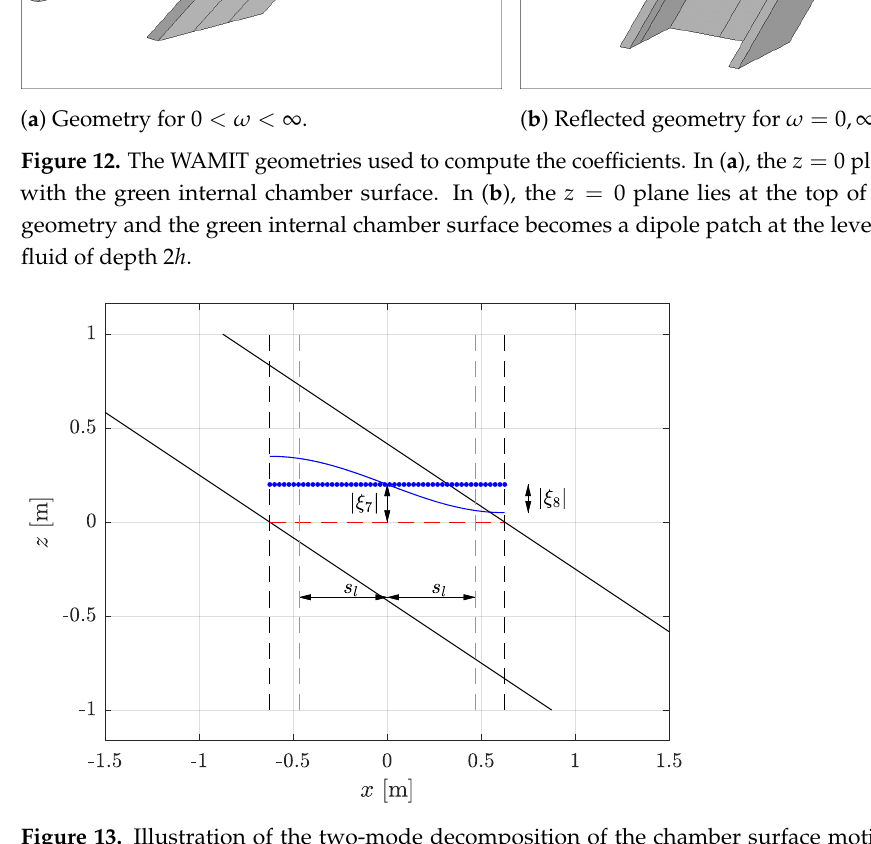
Figure 13. Illustration of the two-mode decomposition of the chamber surface motion using lin- ear theory.